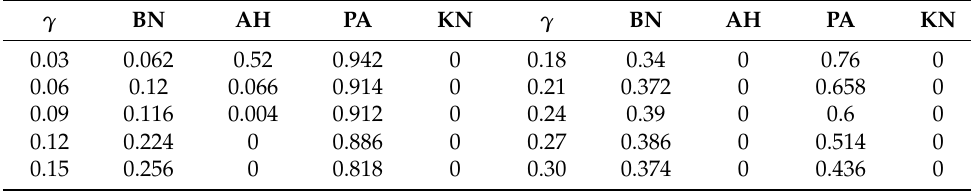
Table 2. Correct rate using various methods of choosing k